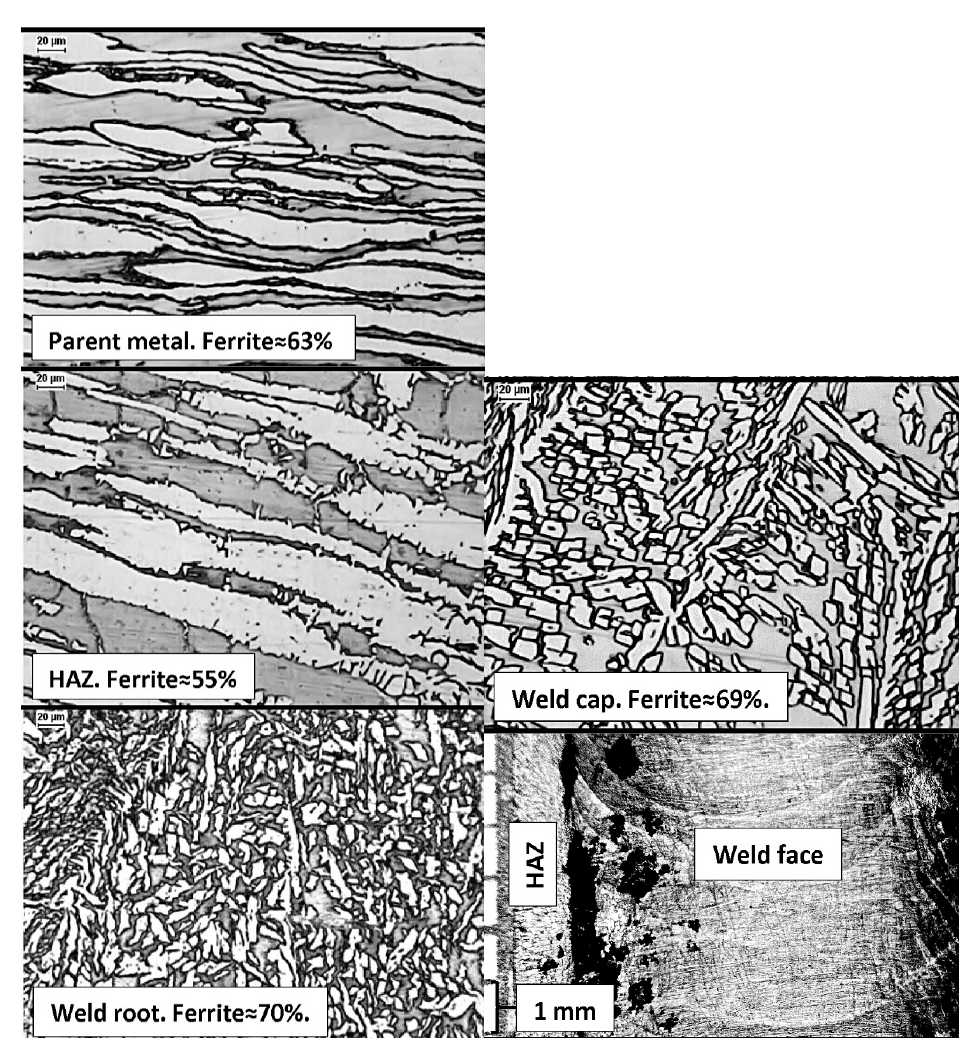
Figure 16. Authors’ analysis of welded connection made of super duplex SDSS steel with a low resistance to pitting corrosion identified for the environment of chlorides. resistance to pitting corrosion identified for the environment of